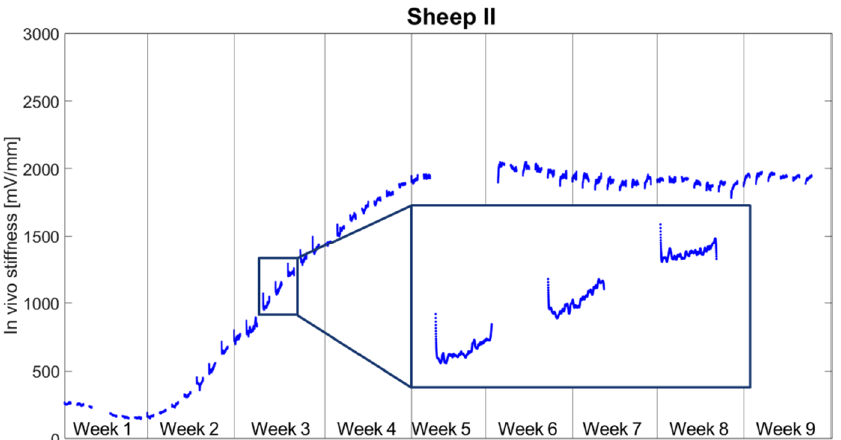
Figure 6. Continuous measurements of the tissue stiffness for Sheep II. Each data point represents one cycle; therefore, each segment shows measurements from 9.00 am to 9.00 pm.